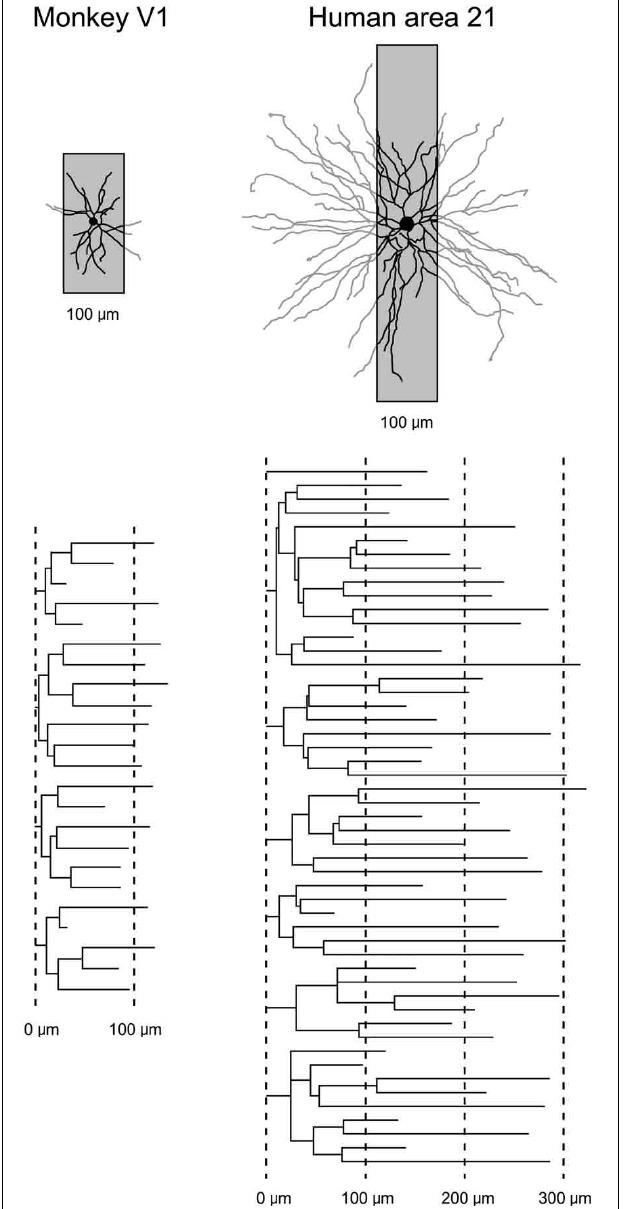
FIGURE 3 | Transverse vs. tangential plane. Schematic illustrating how the study of pyramidal cell morphology in the transverse plane may bias for uniformity in structure. Illustrated are two cells sampled from the primary visual area (V1) of the macaque monkey and Brodmann’s area 21 of the temporal lobe of human (Brodmann, 1909). The basal dendritic trees of the two cells are shown in the tangential plane. Superimposed on each cell is a 100 μ m gray box representing the thickness of section routinely used in Golgi studies. In black is the part of the dendritic tree that would be seen in a Golgi study. In gray is the part of the dendritic tree that would have been clipped off during sectioning and thus invisible to the observer. Below are illustrated the dendrograms of each of the two cells, which resulted from reconstruction of the complete basal dendritic tree as seen in the tangential plane. Based on our observations in the human temporal lobe (Elston et al., 2001), transverse sections used in Golgi studies would have to be > 600 μ m thick, and the cell body located in the center of the section, to be able to visualize all dendrites.